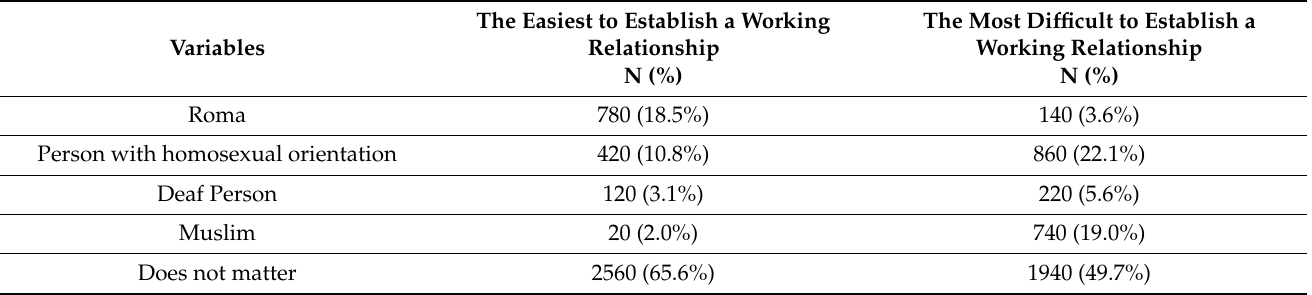
Table 7. Difficulty in establishing professional relations with representatives of selected social groups in the respondents’ opinion.